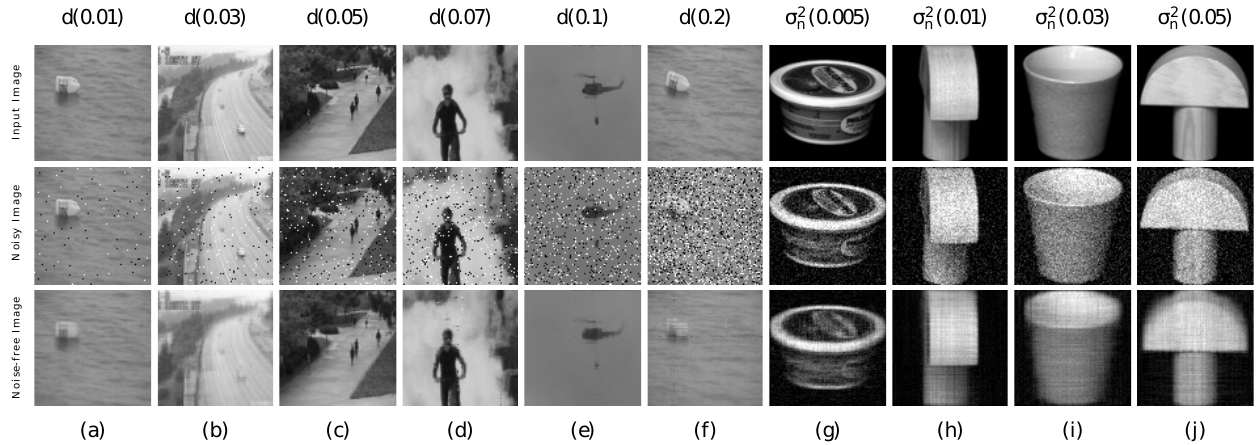
Figure 6. Noise-removed images achieved using proposed method from UCSD and Coil20 datasets for various levels of salt and pepper and Gaussian noise. The noise levels of salt and pepper noise and Gaussian noise are indicated on the top of each input image. First row: original input image, second row: images that have been corrupted by various levels of salt and pepper and Gaussian noise, third row: noise-removed